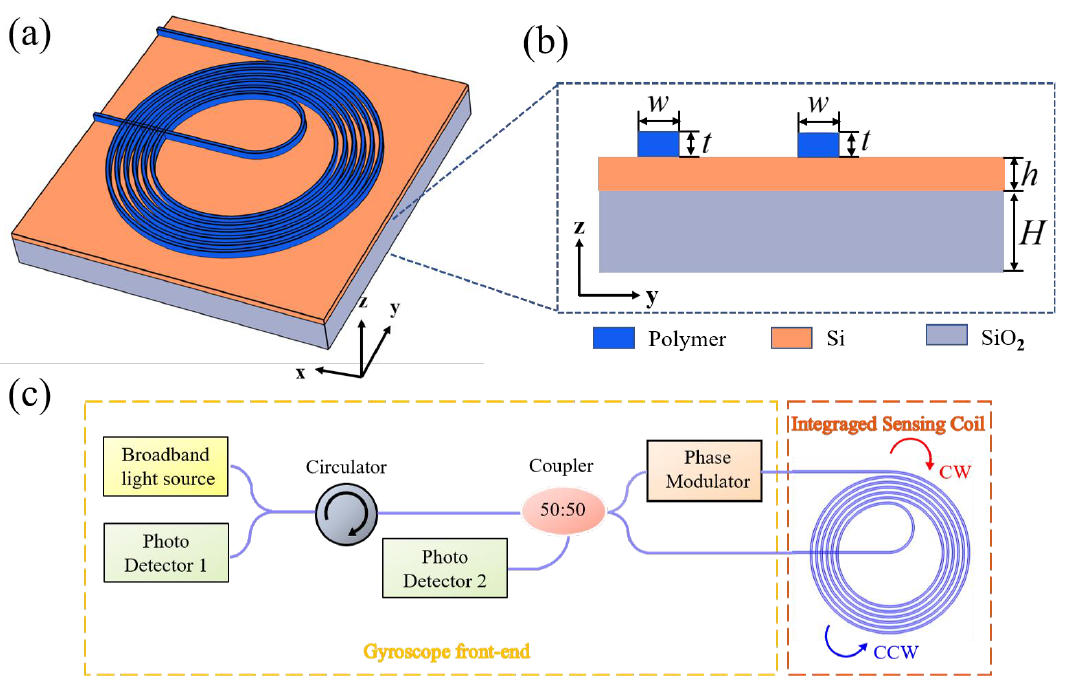
Figure 1. ( a ) Three-dimensional schematic of the Archimedean spiral waveguide structure supporting the BIC mode; ( b ) the cross-section diagram of the designed spiral waveguide structurel ( c ) the schematic diagram of the interferometric integrated optical gyroscope based on the BIC structure.